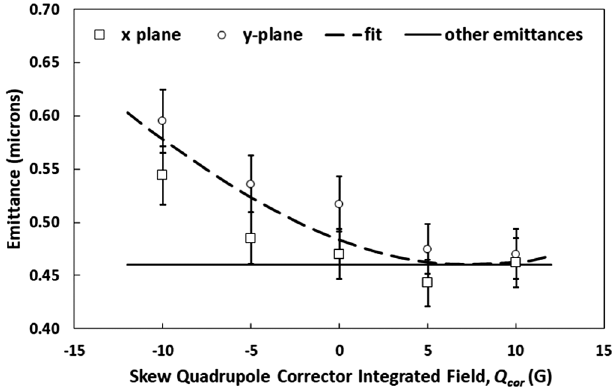
FIG. 8. LCLS injector emittance at 100 pC for the x and y planes vs the skew quadrupole corrector integrated field strength Q . The emittance (points w/error bars) was measured at a beam cor energy of 135 MeV. The dashed curve shows the fit to the data with Eq. (24). The other-effects emittance ϵ is shown by the other solid line at 0 . 46 μ m. The fit indicates that the coupled transverse dynamics emittance growth ϵ is 0 . 15 μ coupled